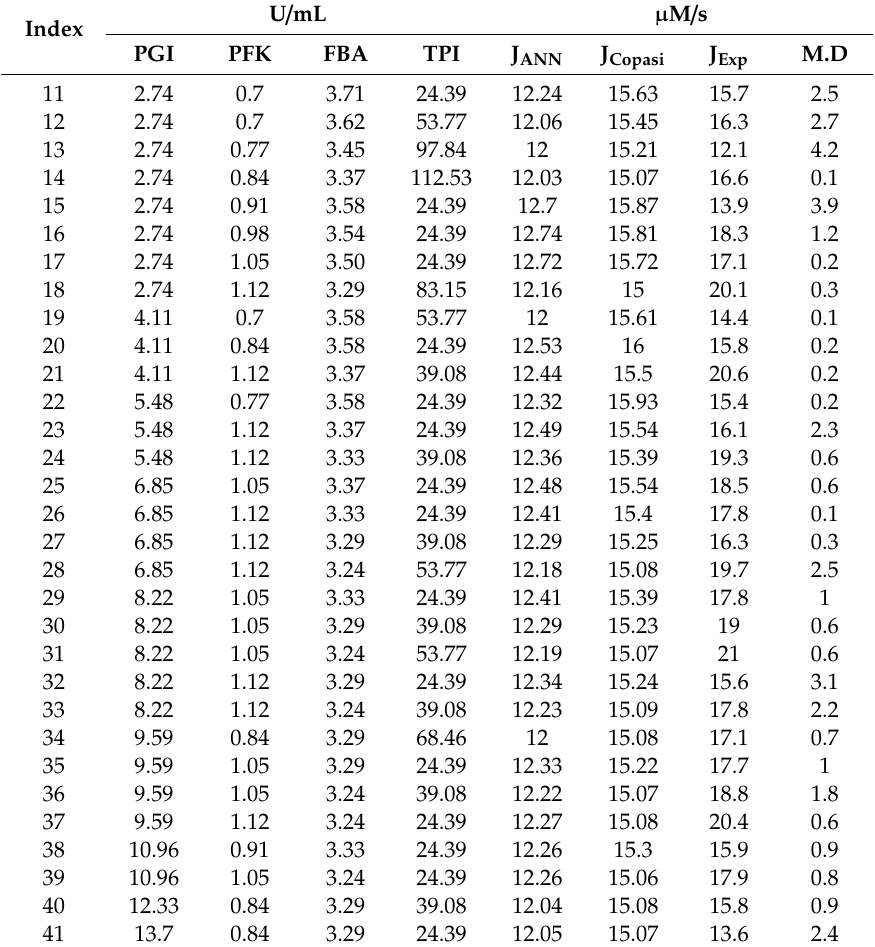
Table 3. Comparison of ANN predicted flux (J ANN in µ M / s), simulated flux (J Copasi in µ M / s) and experimentally assessed flux (J Exp in µ M / s). The four enzymes PGI, PFK, FBA and TPI were used at the indicated concentrations for the experimental assessment of the flux with mean deviation (M.D) of